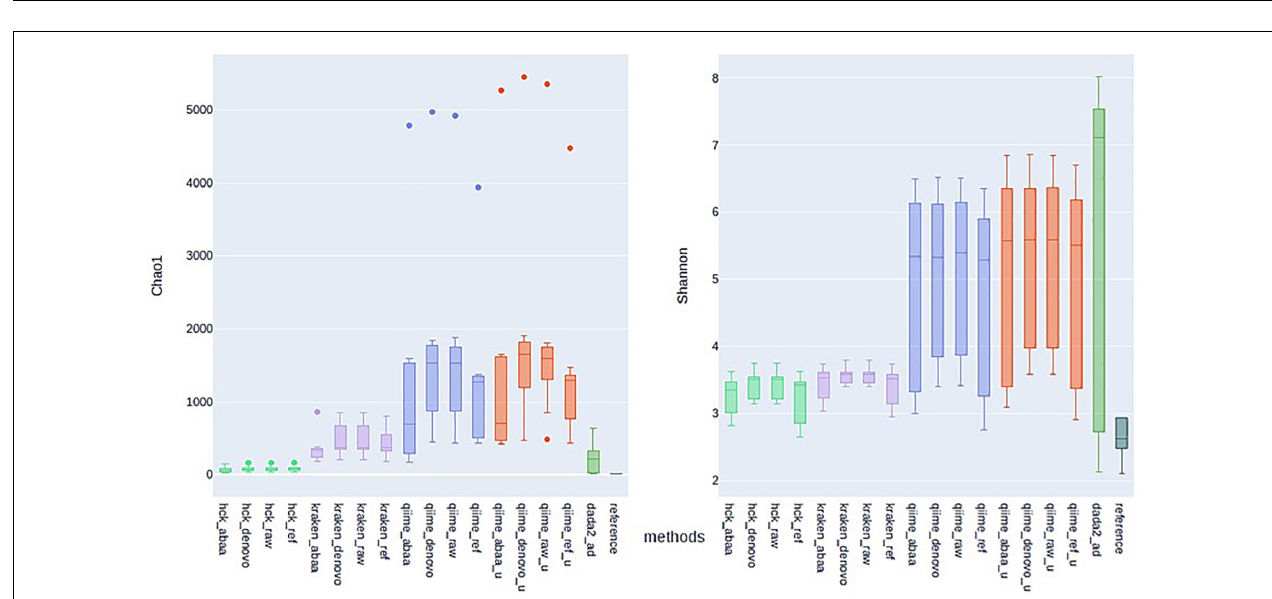
FIGURE 5 | Estimation of Alpha diversity metric with Chao1 (left) and Shannon (right) indexes calculated with the estimated abundance of different methods and association with various chimaera removal methods